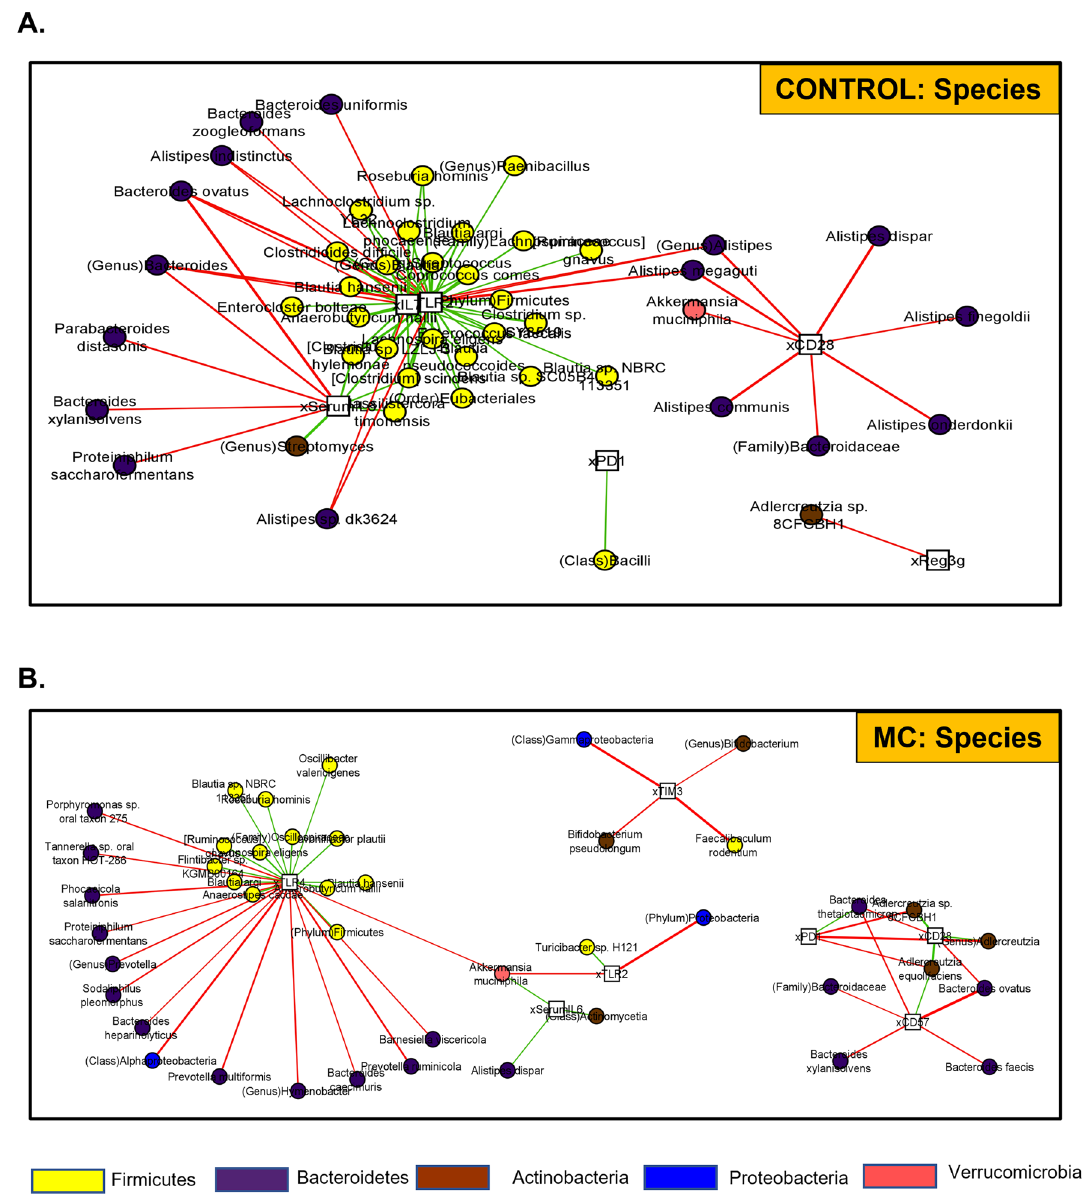
Figure 7. Correlation networks with the abundance of taxa and resistance genes. ( A ) CONTROL and ( B ) MC groups co-occurrence networks built with Pearson correlations (p = 0.01) between microbial abundances (circles) and gene expression values (squares), separately normalized to avoid compositional dependencies. Green edges indicate positive correlations, and red edges are negative correlations. Networks have been visualized with the Fruchterman-Reingold algorithm applied to positive